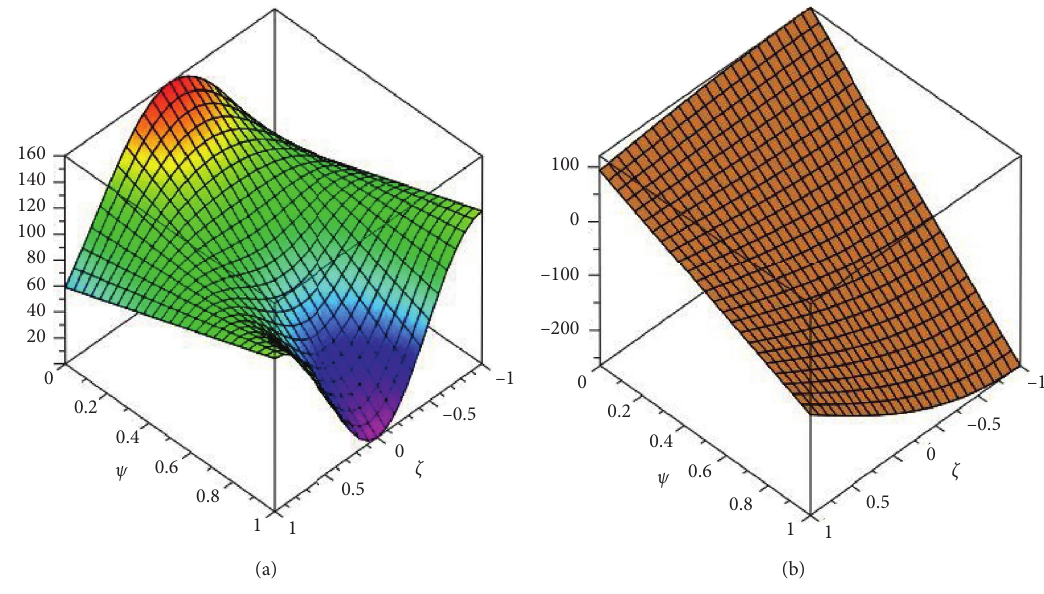
Figure 2: LADM solutions of μ ( ζ , Ψ ) and ρ ( ζ , Ψ ) at c �